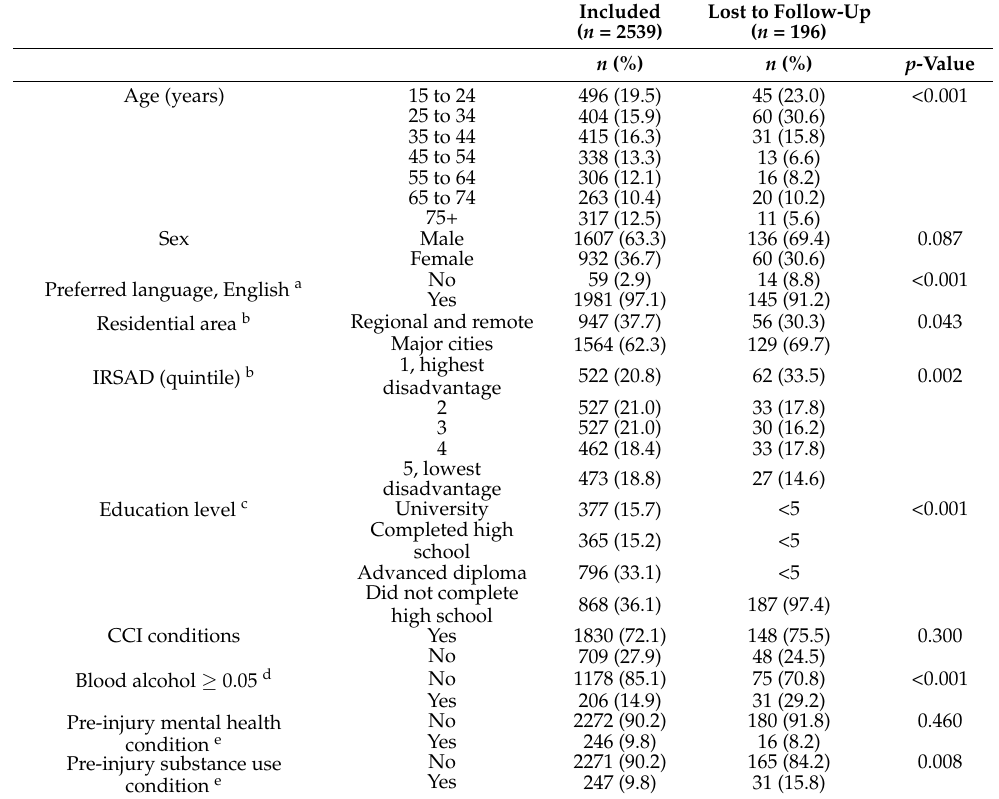
Table 1. Characteristics of the participants who were included in the study, and people who were completely lost to follow-up for EQ-5D, GOS-E or return to work outcomes analyses, N =